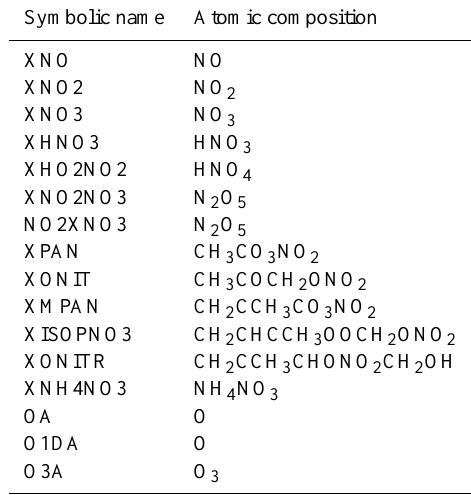
Table 1. Tagged species in the MOZART-4 tagged ozone mecha-